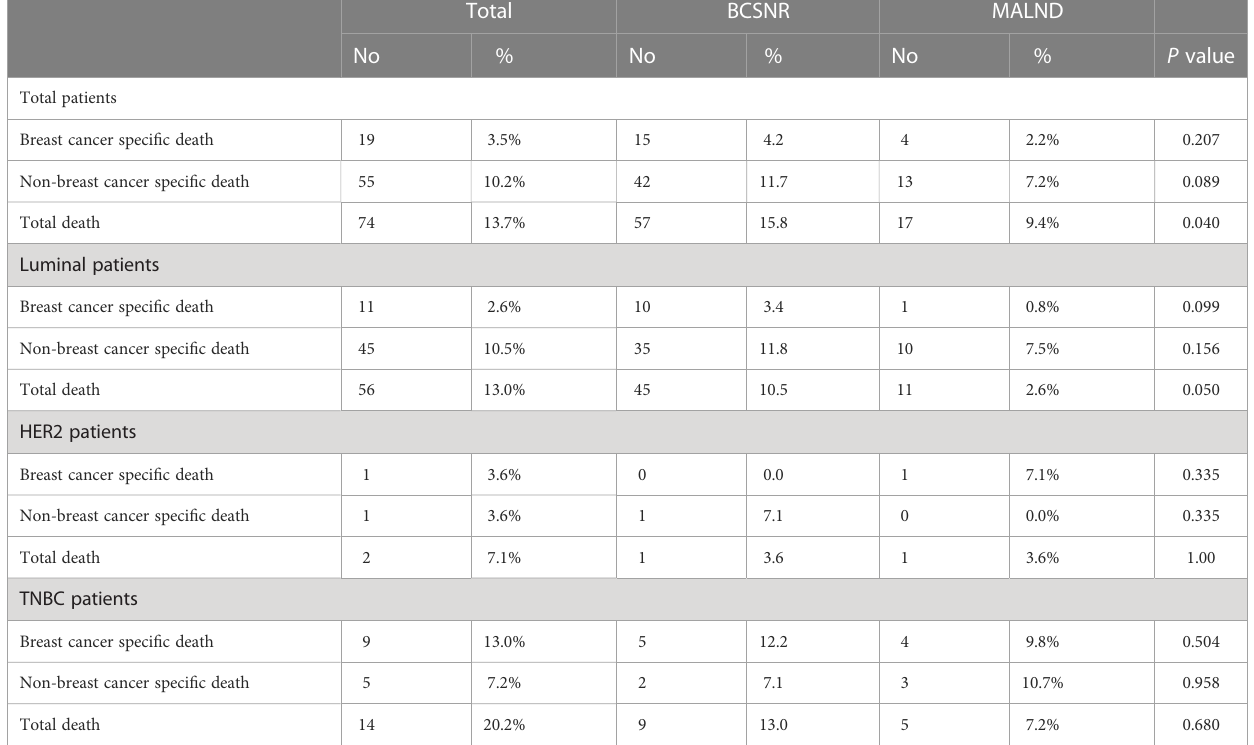
TABLE 4 Breast cancer speci fi c death and non-breast cancer speci fi c death according to operation method.